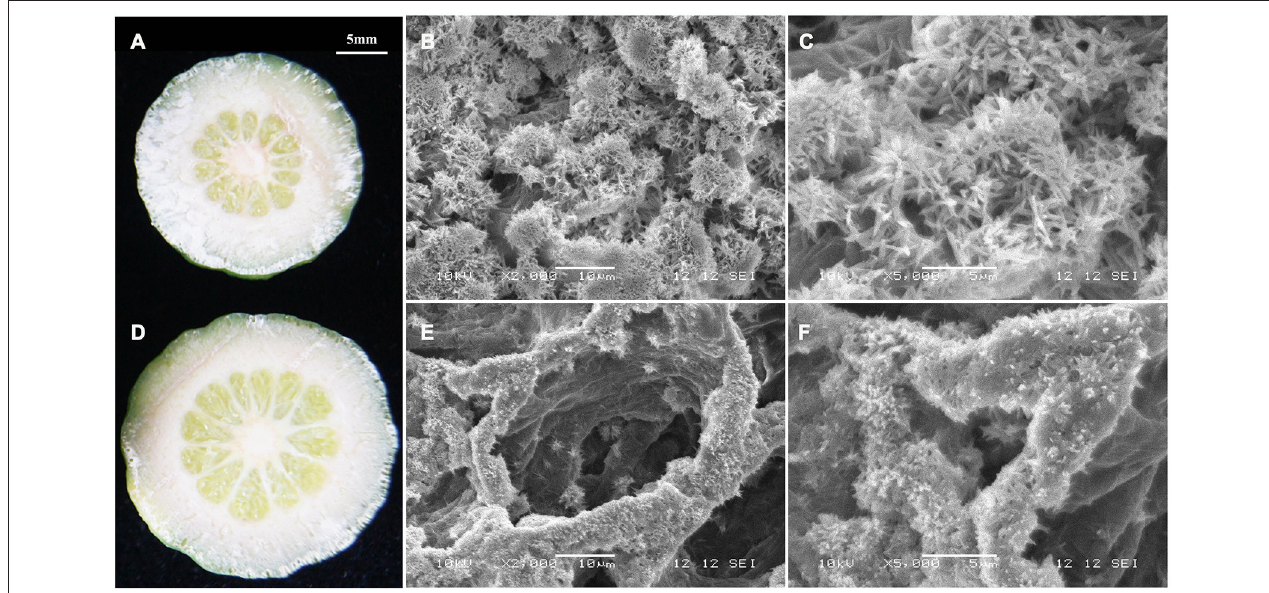
FIGURE 7 | Morphology of starch in CK peel (A–C) and RD peel (D–F) at 30 DAFB.